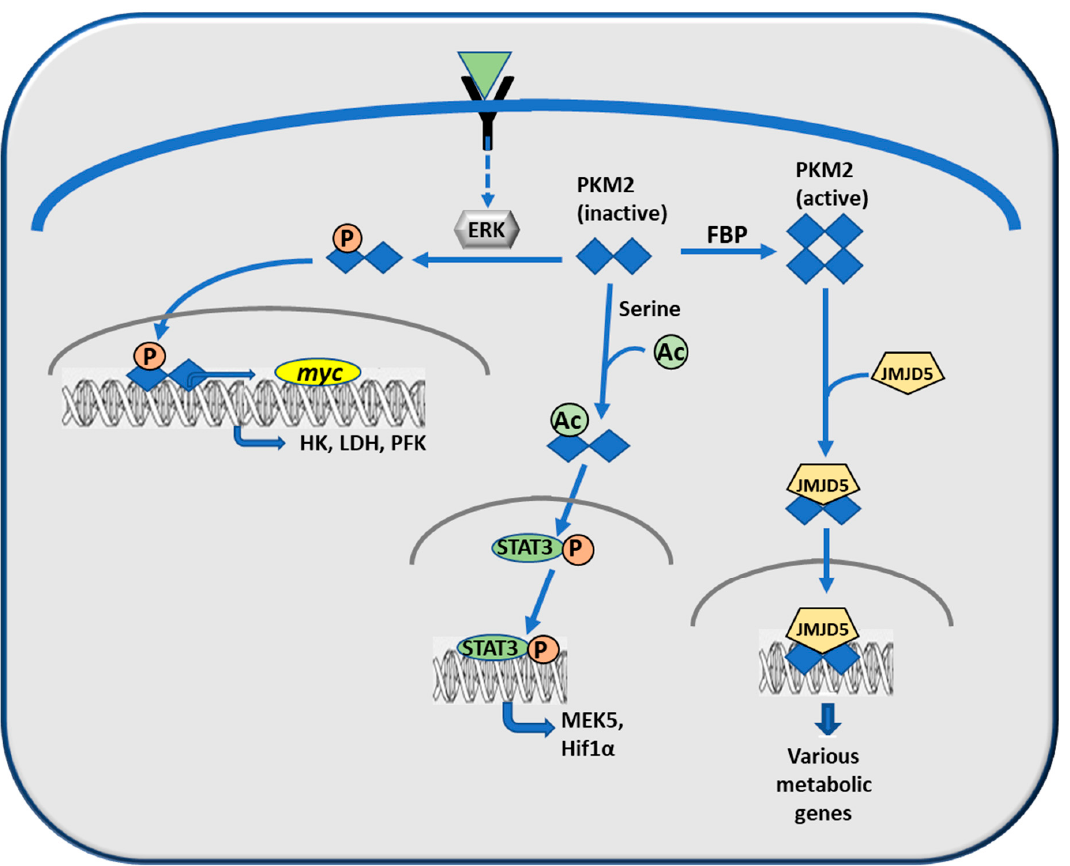
Figure 5. Modifications of dimeric and tetrameric PKM2 and nuclear effects of the different forms. Explanations in the text.